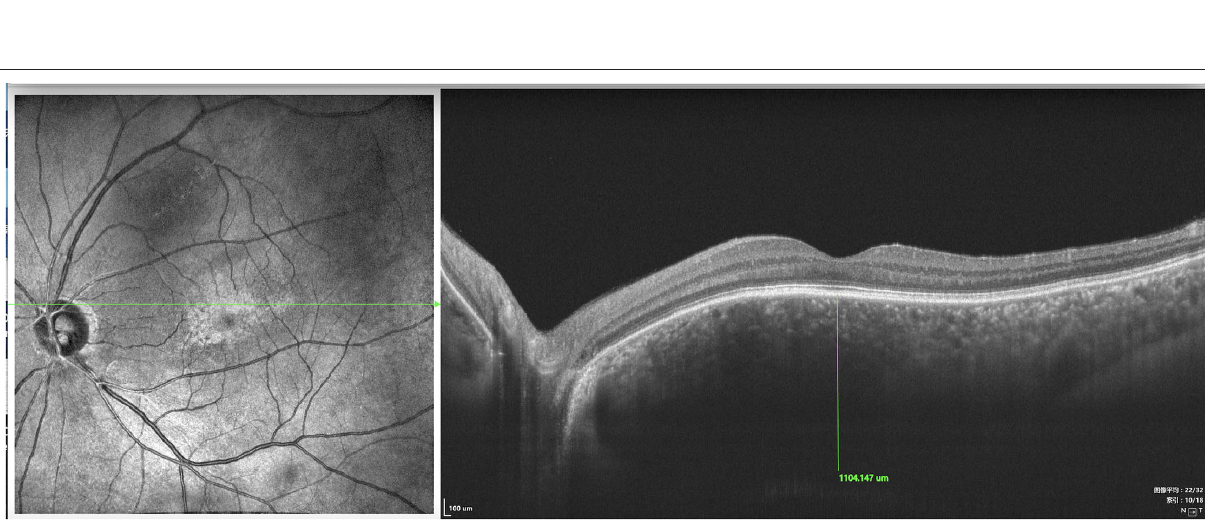
photoreceptor and RPE damage, flattening of crowded